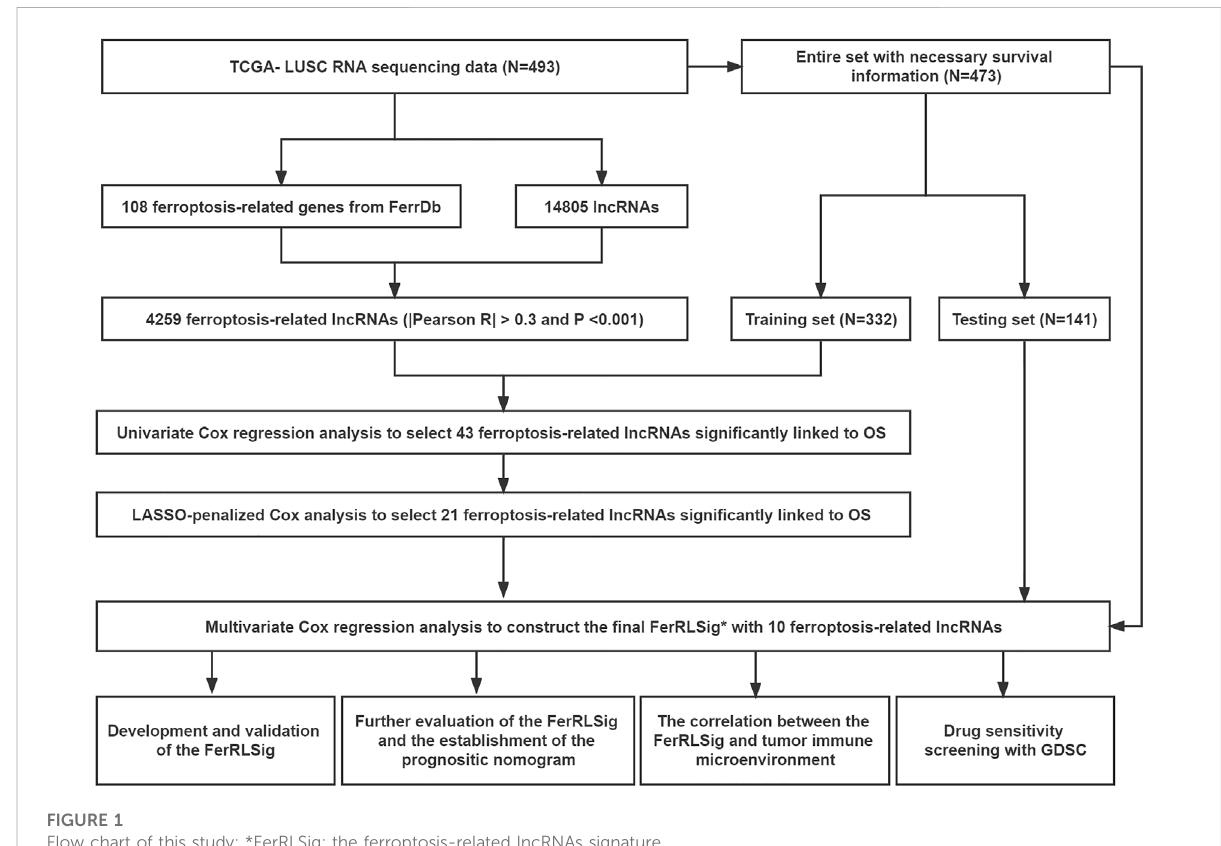
FIGURE 1 Flow chart of this study; *FerRLSig: the ferroptosis-related lncRNAs signature.